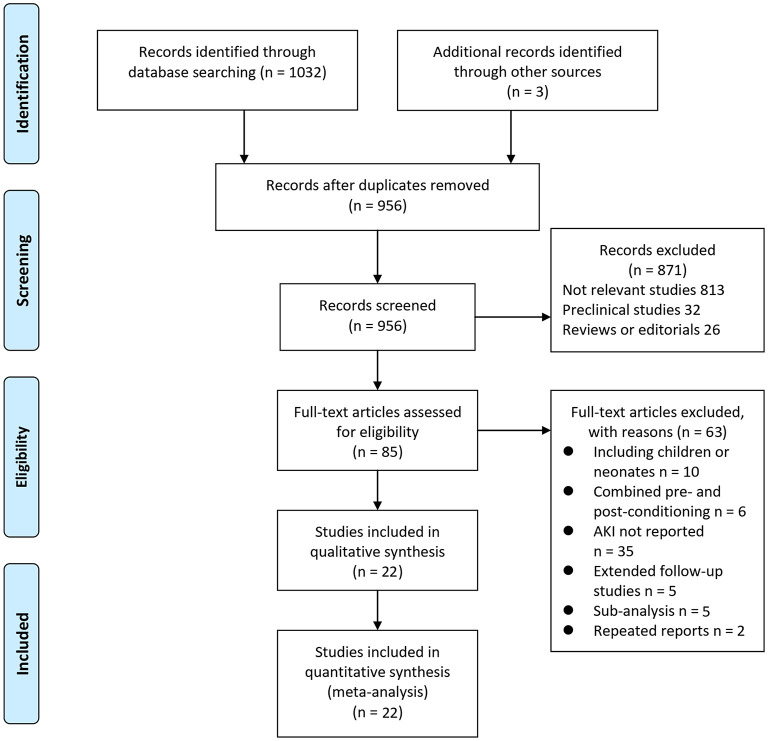
Flowchart of literature search.